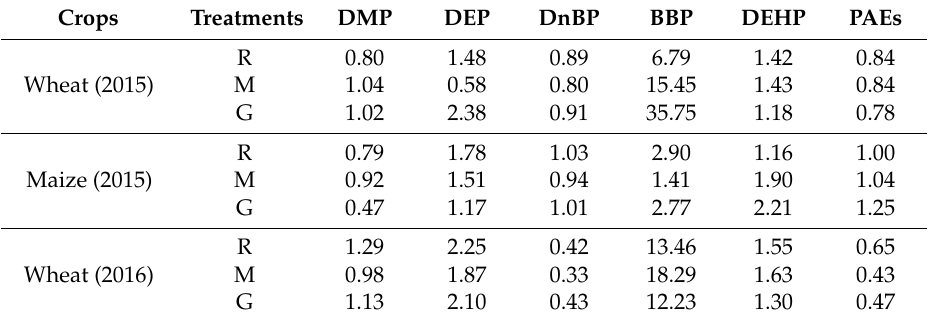
Table 7. The bioaccumulation factors of each PAE in the soil-cereal grain system in 2015 and 2016. Crops Treatments DMP DEP DnBP BBP